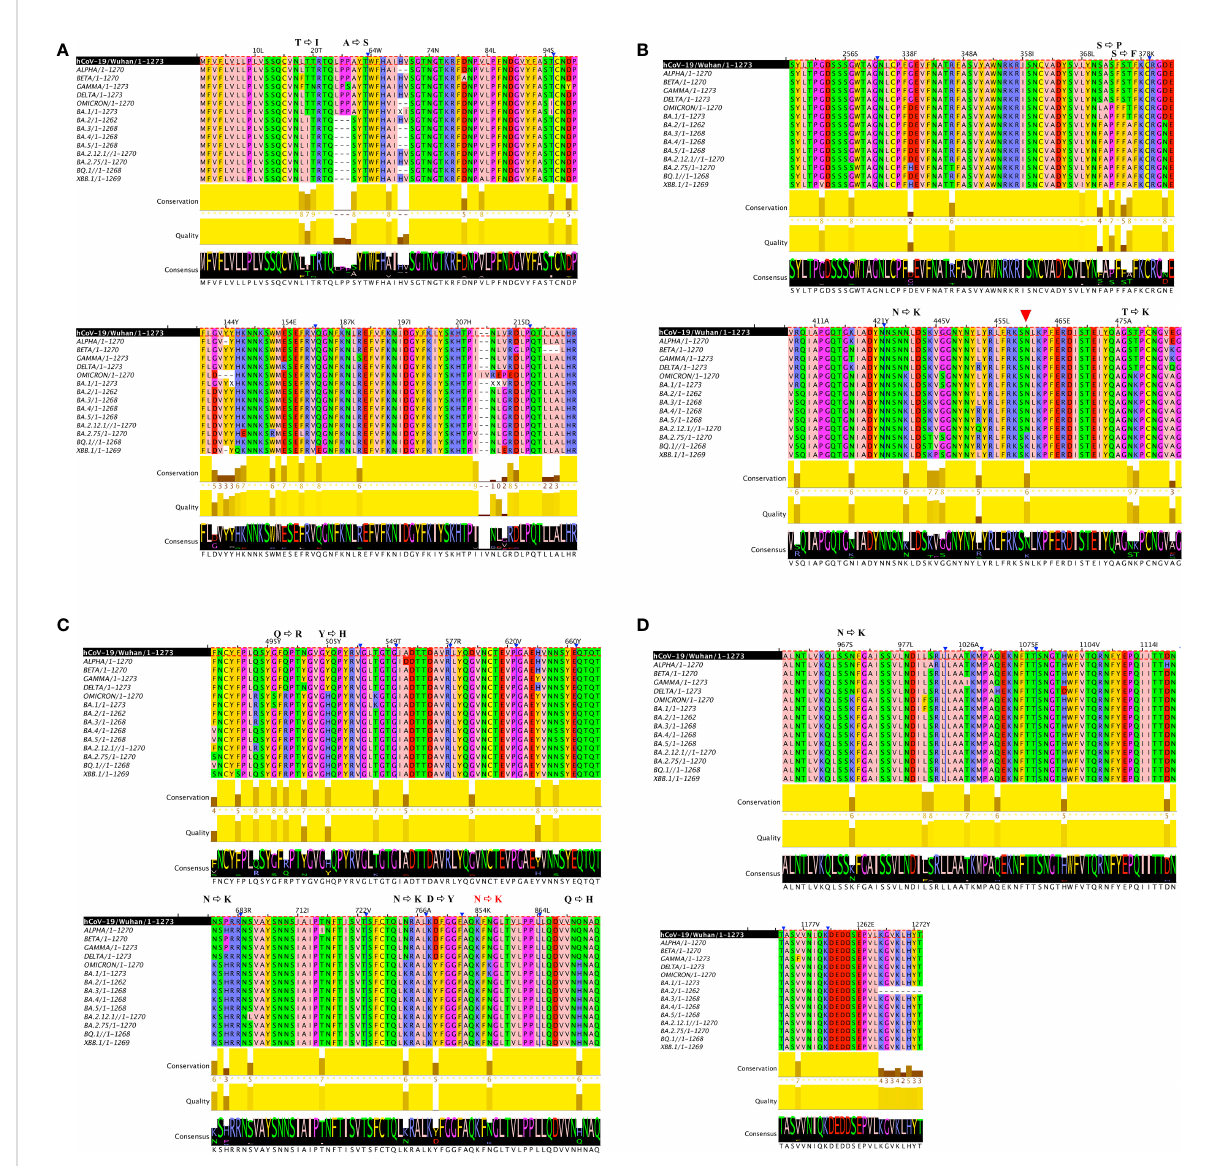
FIGURE 1 Multiple alignments in 6 VOC strains. Multiple sequence alignment of full-length Spike proteins of Alpha, Beta, Gamma, Delta and Omicron SARS-CoV-2 VOCs including it ’ s subvariants (BA.1, BA.2, BA.3, BA.4, BA.5) as well as currently emerging variants (BQ.1 and BBX.1) show a distinct preference for N to K transition in the Spike region. (A) is fi rst portion of the Spike protein (B) second portion of the Spike protein, red arrow indicates another NtoK transition acquired (C) third portion of the Spike protein, NtoK in red indicates a lost mutation (D) fi nal portion of the Spike protein. In order to facilitate localization of where mutations have occurred, in (A-C) a truncated Spike protein is depicted, blue arrows and lines indicate the sites where a portion of the amino acid sequence is not visible. Full length Omicron protein with annotated mutations can be viewed in Figure S1A –